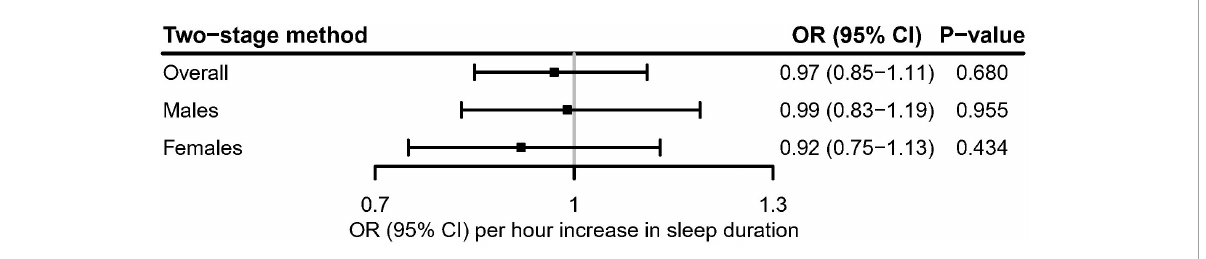
FIGURE3 Linear Mendelian randomization estimate for the association between genetically predicted continuous sleep duration and hyperuricemia in the UK Biobank using the two-stage method. After correcting for multiple comparisons, P < 0.05/3 = 0.017 was considered significant.